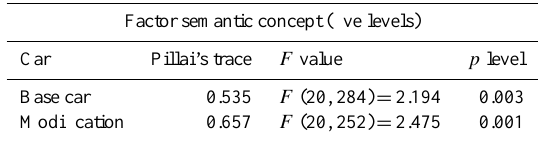
Table 2. Results of within-subject repeated-measures ANOVA.